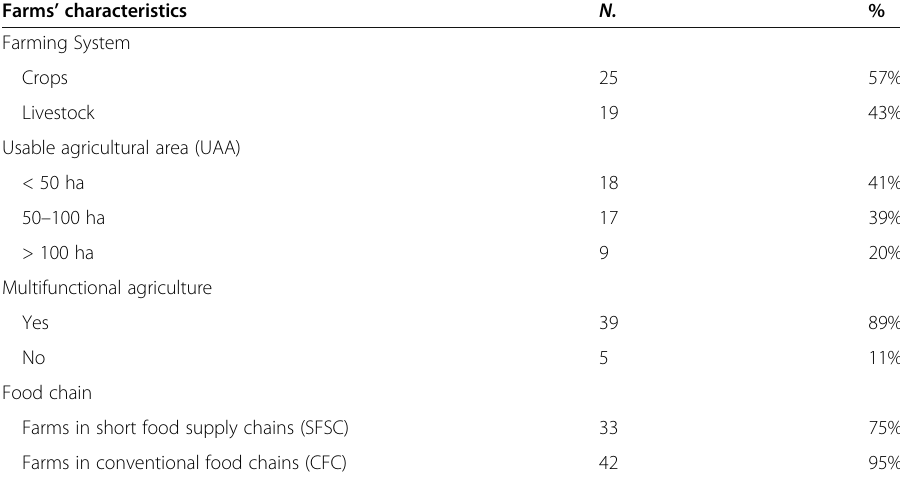
Table 1 Characteristics of the analyzed sample. Multifunctional agriculture and SFSC are explained in Table 2 Farms ’